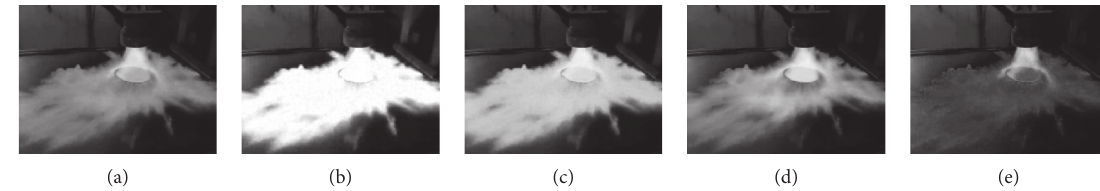
Figure 2: The comparison results of flame image I under different methods: (a) average method; (b) maximum method; (c) weighted average method 1; (d) weighted average method 2; (e) weighted average method 3.